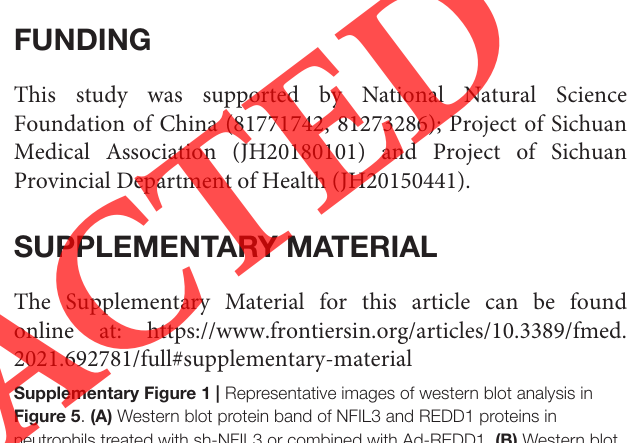
Supplementary Figure 1 | Representative images of western blot analysis in Figure 5 . (A) Western blot protein band of NFIL3 and REDD1 proteins in neutrophils treated with sh-NFIL3 or combined with Ad-REDD1. (B) Western blot protein band of p-S6 and p-4EBP1 in neutrophils treated with sh-NFIL3 or combined with Ad-REDD1. (C) Western blot protein band of LC3 II protein in neutrophils treated with sh-NFIL3 or combined with Ad-REDD1. Supplementary Figure 2 | Representative images of western blot analysis in Figure 6 . (A) Western protein band of NFIL3 in the neutrophils of the joint tissues of mice. (B) Western blot protein band of REDD1 in the neutrophils of the joint tissues of mice. (C) Western blot protein band of S6, 4EBP1, p-S6, and p-4EBP1 protein expression. (D) Western blot protein band of LC3 I and LC3 II protein expression. Supplementary Table 1 | Clinical characteristics of gout patients and healthy controls. Supplementary Table 2 | Primer sequences for reverse transcription quantitative polymerase chain reaction. Supplementary Table 3 | The differential expression of the seven transcription factors in the dataset. Supplementary Table 4 | Prediction result of the JAPSPAR